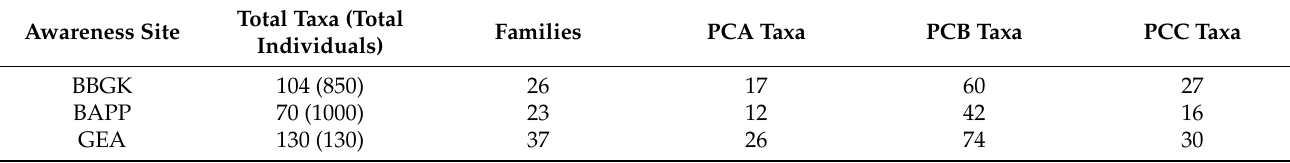
Table 6. Floristic composition in priority plants (planted individuals of taxa, representation of different families) of different awareness-raising sites (BBGK, Balkan Botanic Garden of Kroussia; BAPP, Botanical Awareness Public Park in Kardia; GEA, Garden of Environmental Awareness in Thermi, all in Northern Greece). PCA, Threatened and Near Threatened plants; PCB, Local Balkan endemics and subendemic plants; PCC, Regionally rare and/or uncommon